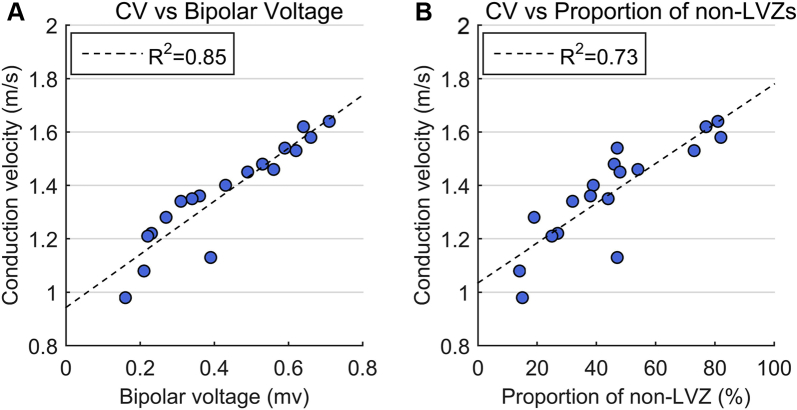
Relationship between mean CV for each patient at pacing interval of 600 ms (the average of all the CV measured between all pole pairs in each patient) and mean bipolar voltage including all bipolar voltage points in each patient (A) and the proportion of non-LVZs in each patient (B). CV = conduction velocity; LVZ = low-voltage zone.